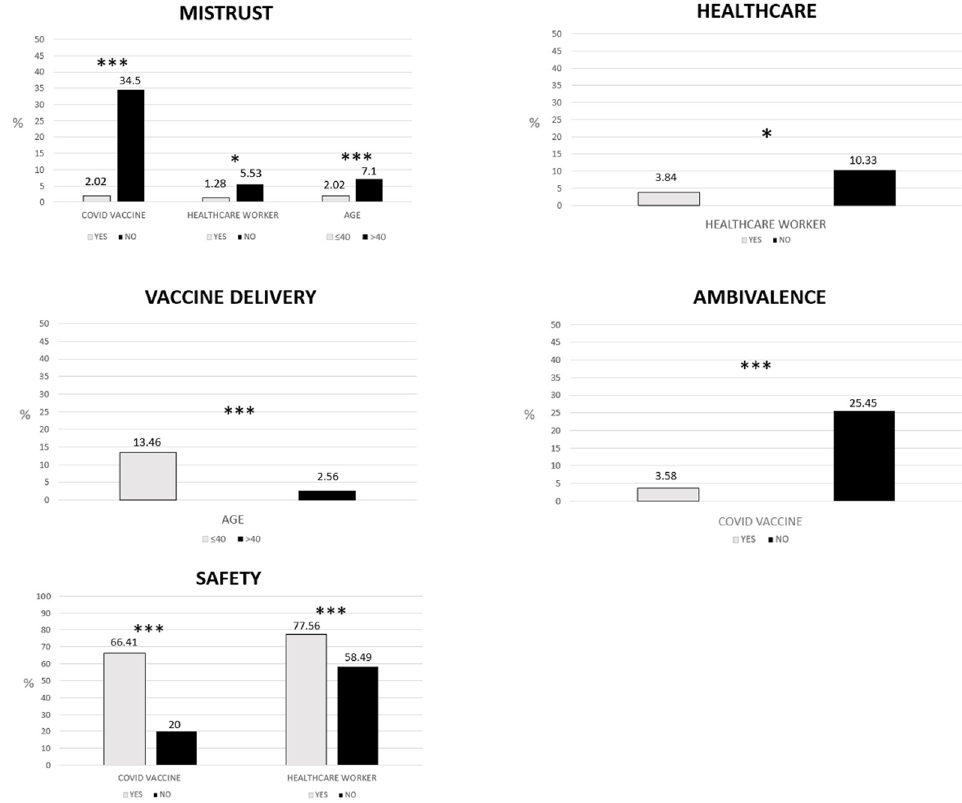
Figure 1. Statistically significant differences in the prevalence of themes. Only statistically significant differences are shown. * p < 0.05, *** p < 0.001. Comparisons were tested with chi-square. Fisher’s test was performed for categories with N ≤ 5 .